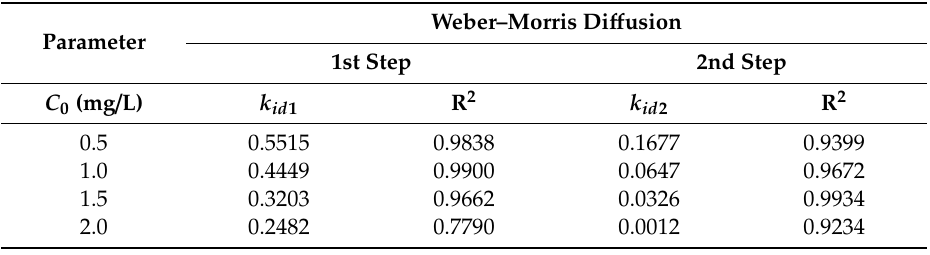
Table 3. Rate constants for the kinetic model of the adsorption of As(V) on NZVI / AC at di ff erent adsorbent dosages.